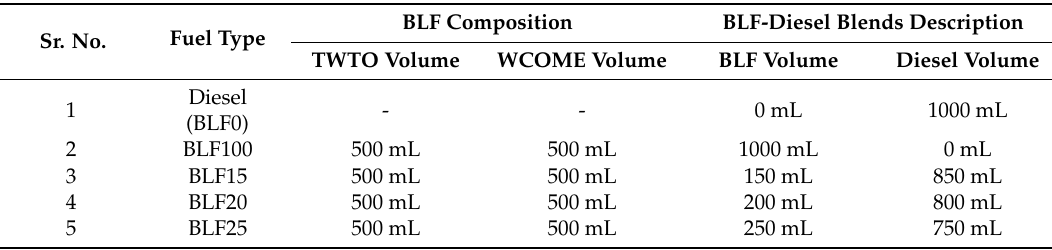
Table 1. Composition of BLF and its